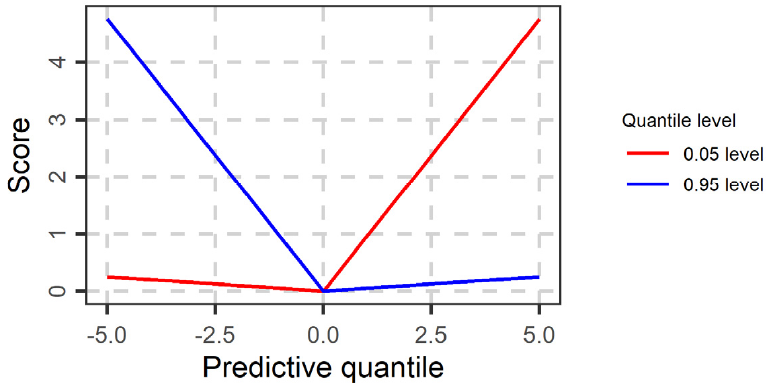
Figure 1. Illustration of the quantile score (value of the quantile loss function) at the quantile levels a ∈ {0.05, 0.95} when x = 0 materialises and for varying predictive quantiles r (see Equation (3)).